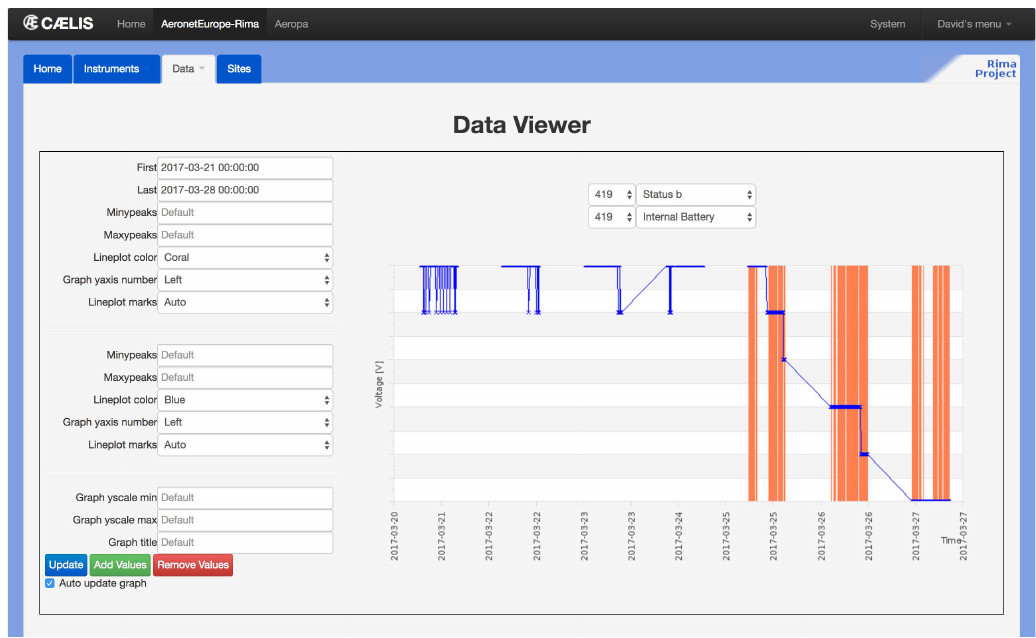
Figure 10. An example of data viewer where an instrumental error can be identified. The power supply is disconnected and the internal battery decreases. When energy it is not enough to move the robot, “status b” (robot) errors appear. Each orange vertical line represents a status error in an specific